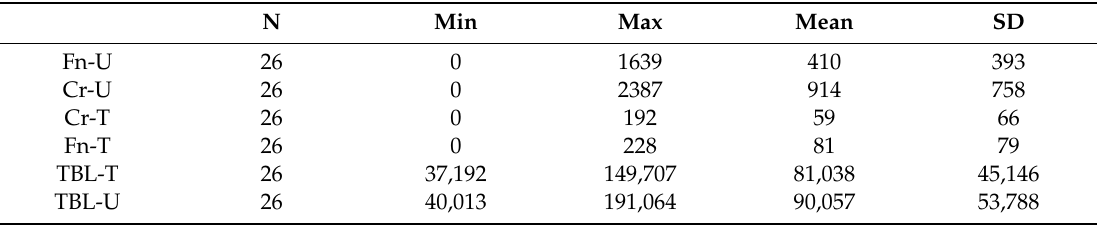
Table 2. Bacterial count observed for treated with the alcoholic solution containing polysiloxane